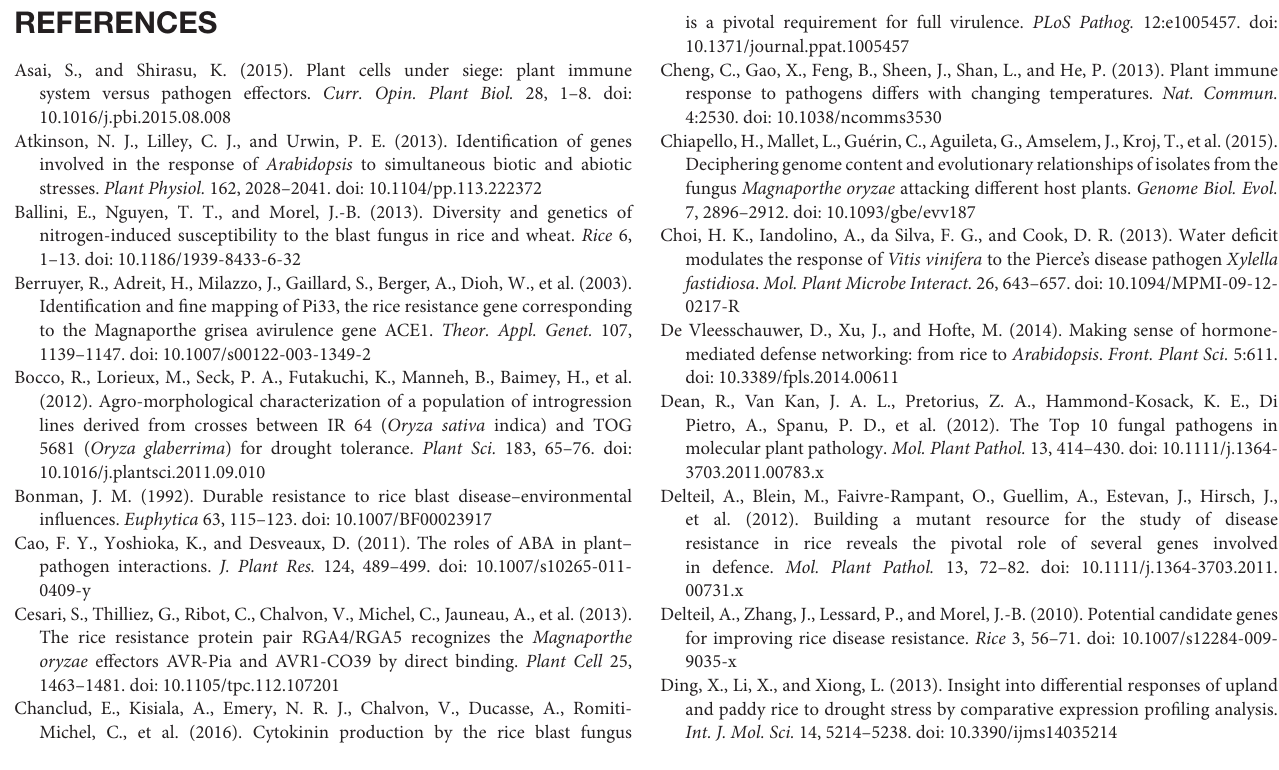
FIGURE S2 | Drought-induced susceptibility in different rice accessions. All plants were grown as in Figure 1 (3 days drought then re-watering) and inoculated with the Guy11 or the CL367 isolate of M. oryzae. Symptoms were taken at 7 dpi. The number of grayish lesions is indicative of the susceptibility level. FIGURE S3 | In planta expression of various fungal pathogenicity genes after drought. Gene expression of two biotrophic effectors fungal effectors (SLP2, BAS1), one necrotrophic effector (NEP1) and of the pathogenicity regulator MSP1 was measured by RT-qPCR during all fungal cycle in plants that experienced no stress (gray) or 3-day drought (black bars). The expression was normalized with the constitutive fungal gene MG4. The data represent the mean and SD from four replicates. A t -test was used to compare gene expression in non-stressed and 3-day stressed plants ( ∗∗ P < 0.01; ∗ P < 0.05). FIGURE S4 | Plant gene expression after inoculation and drought stress. Rice gene expression was measured by RNAseq (see Materials and Methods) at 4 dpi in Nipponbare plants infected with the M. oryzae FR13 isolate. DEG analysis allowed the identification of several expression patterns and the five major ones are shown: drought-specific (D), M. oryzae specific (Mo), showing enhanced regulation (enh), non-predictable expression (not pred) and canceled (Canc). Each pattern could be subdivided depending on the induction (I) or repression (R) of the corresponding genes. For each group of genes, the average and SD values (after normalization) are shown. The letters above each condition reflect the statistics of each individual gene in each group. The number of genes in each pattern is indicated between brackets. (A) genes regulated by drought only, (B) genes regulated by infection only, (C) genes whose induction by infection is enhanced by drought, (D) genes whose expression cannot be predicted from single stresses, and (E) genes whose regulation by infection is cancelled by drought. TABLE S1 | Primers used for RT-qPCR. TABLE S2 | Magnaporthe oryzae gene differentially expressed in drought-stressed plants compared to unstressed plants. TABLE S3 | Rice genes showing dual effect of drought and